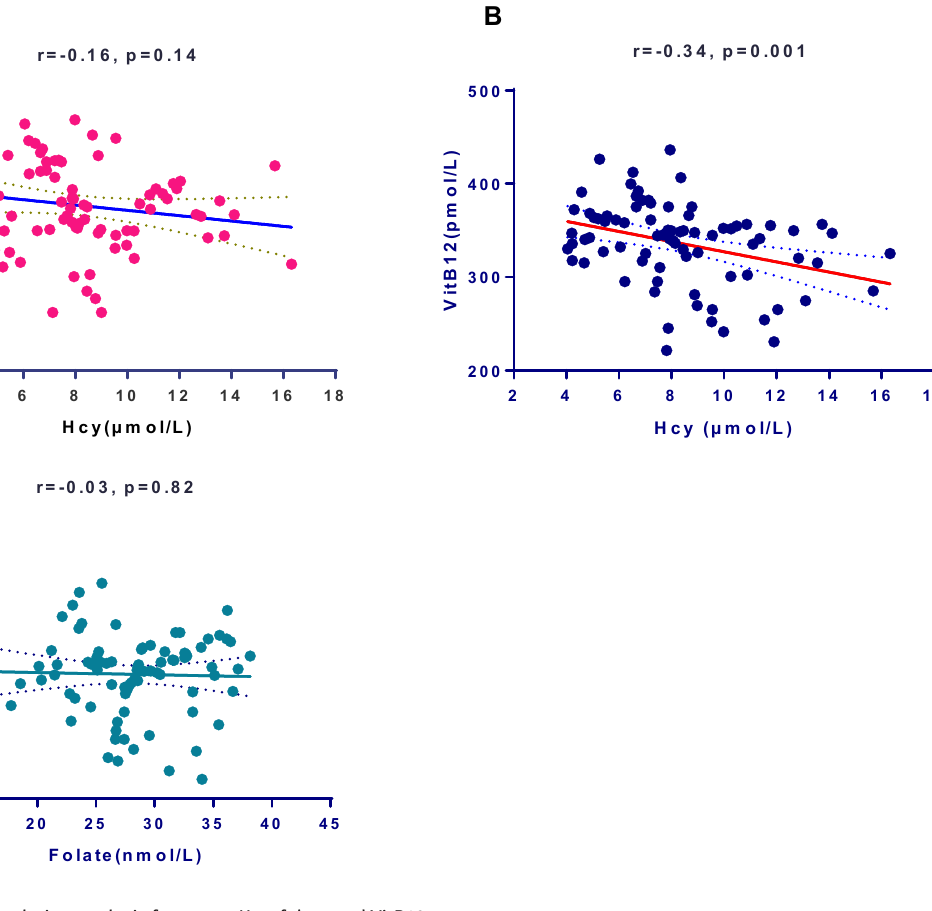
Figure 2: Pearson correlation analysis for serum Hcy, folate and